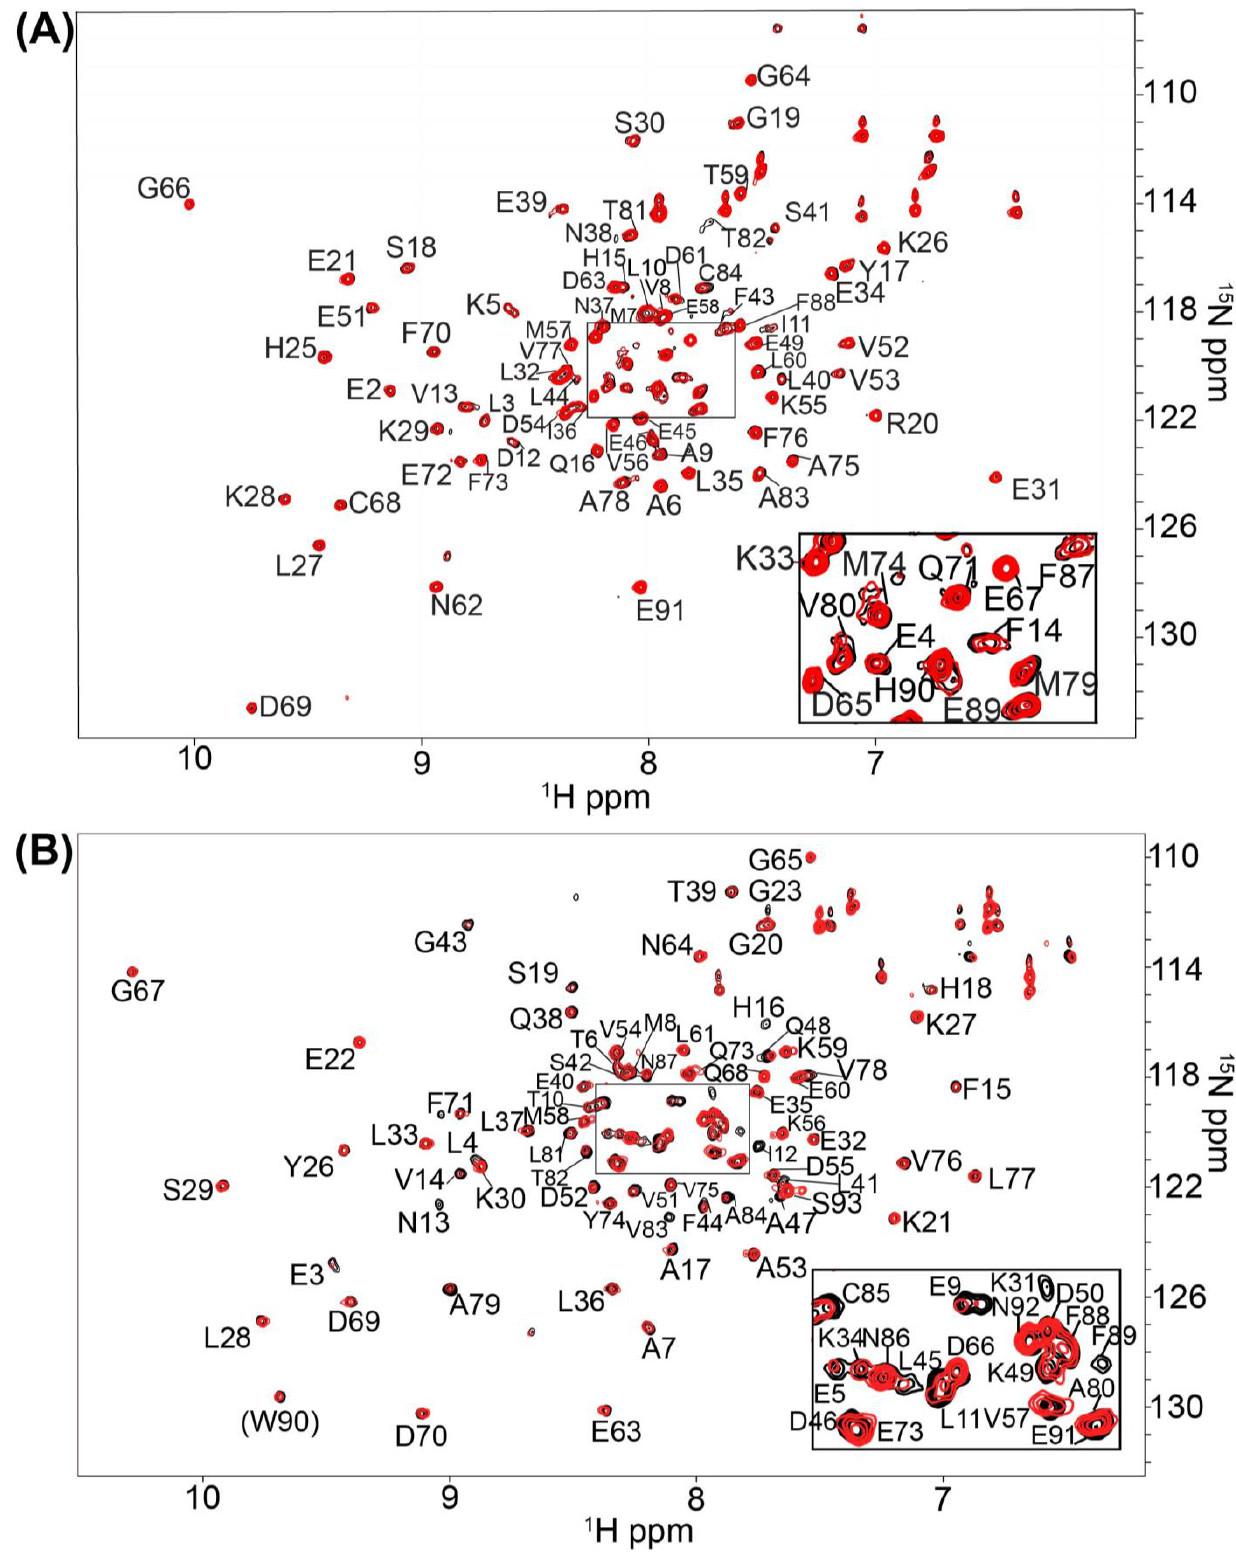
Figure 5. NMR data of S100B and S100A1 bound to the S100A1 specific inhibitor KM01765. 2D-[ 1 H, 15 N]-HSQC overlays of ( A ) Ca 2+ -S100B and ( B ) Ca 2+ -S100A1 with (red) and without (black) the S100A1-specific compound KM01765. The NMR data was col- lected in the same manner for both S100 proteins under identical buffer conditions, at 800 MHz, 37 °C, as described in Methods.